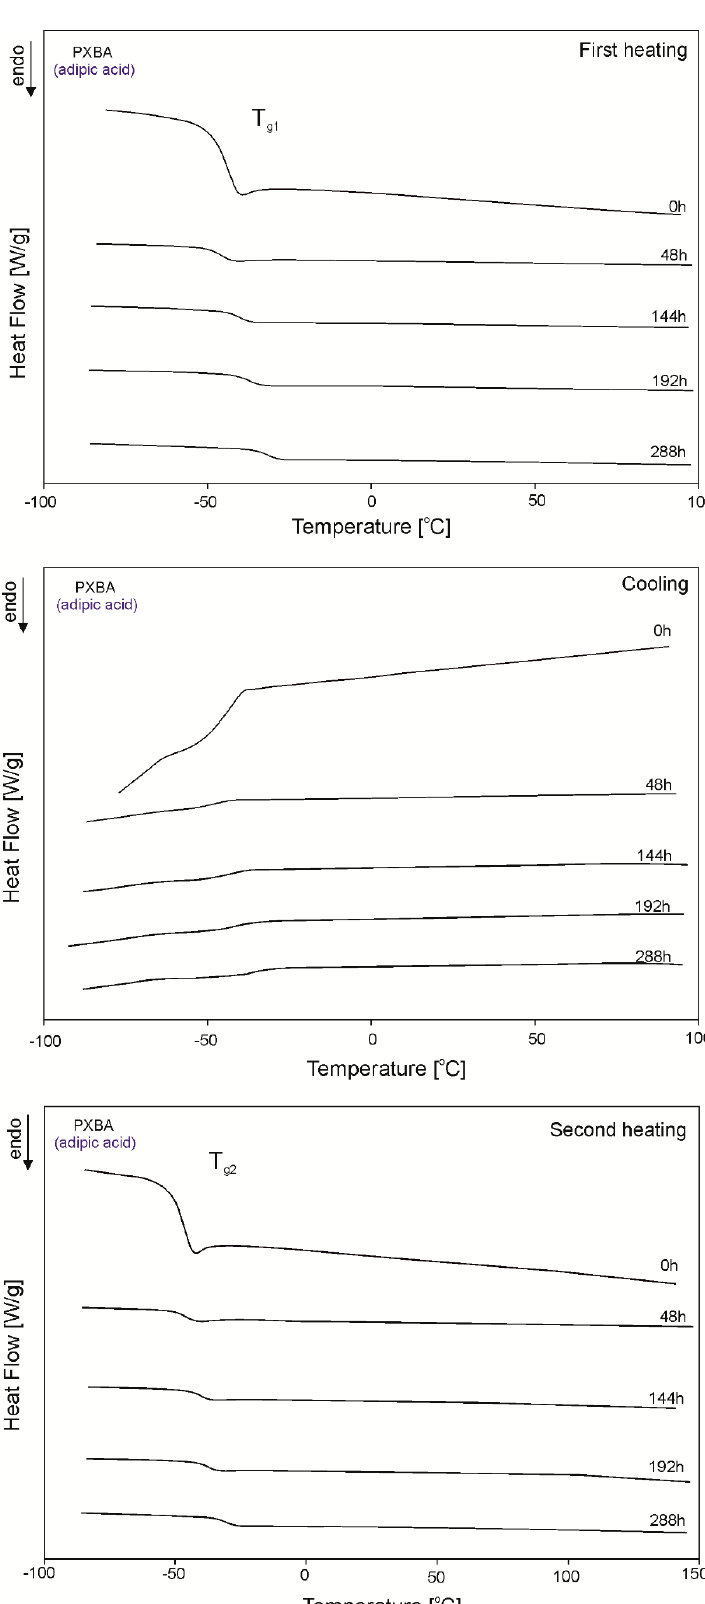
Figure 5. Differential scanning calorimetry (DSC) thermograms of PXBSu at the crosslinking stages subjected to first heating, second heating and cooling.